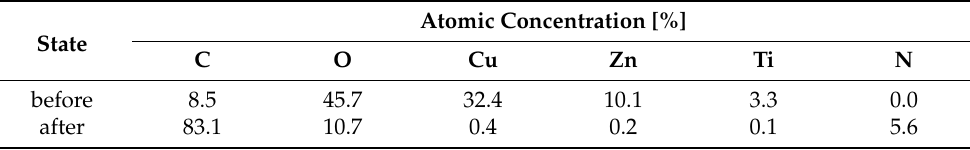
Table 2. Atomic concentrations of the elements at the surface of powder oxides (filler) before and after contact with melted PA12.